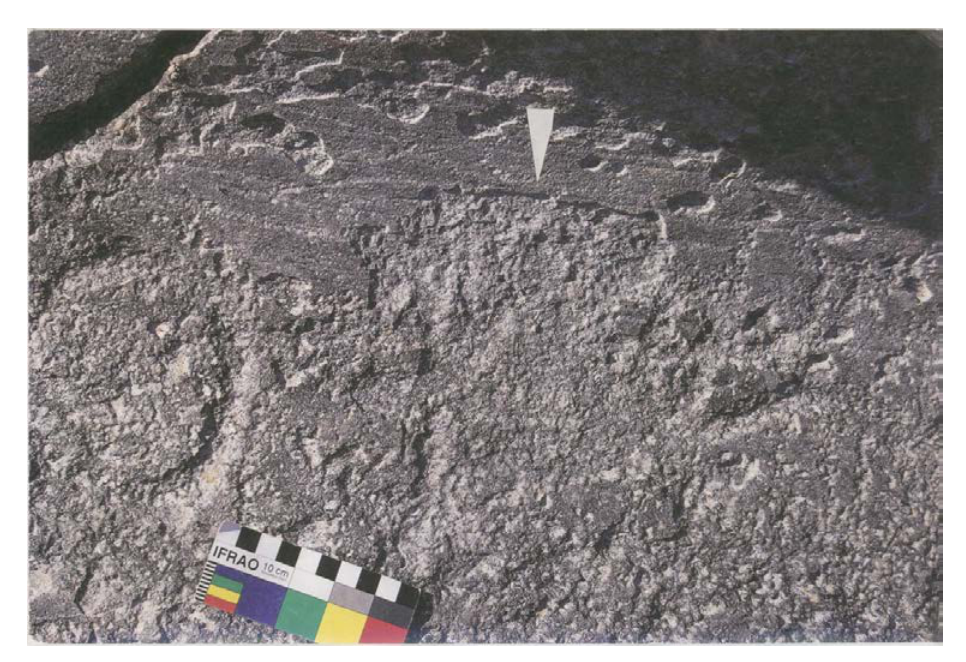
Figure 12. Arrow points to a naturalistic, solidly pecked bison image on the main panel of the Hensler Petroglyph Site. Photo by